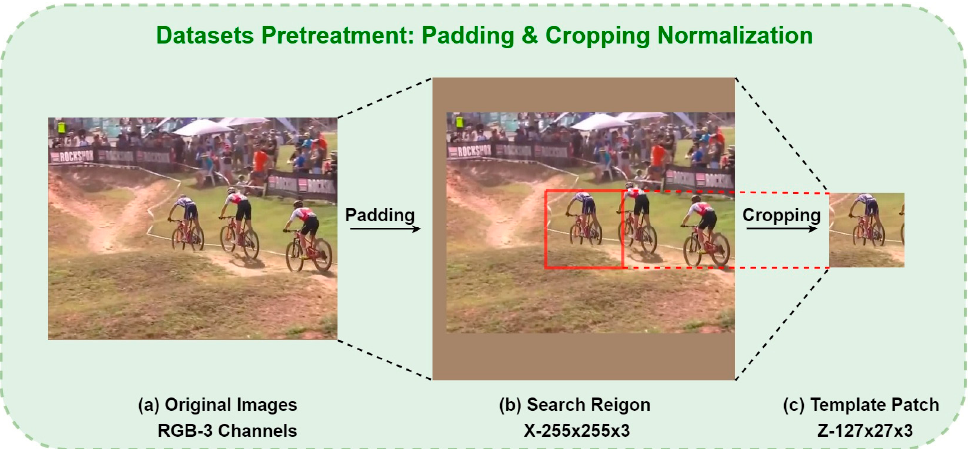
Figure 7. The process of datasets pretreatment: padding and cropping normalization. The ( a ) original images are adjusted through the padding process to be 255 × 255 as the inputs of the ( b ) search region branch X, and then are cropped to 127 × 127 as the inputs of the ( c ) template patch Z branch using the ground truth information.